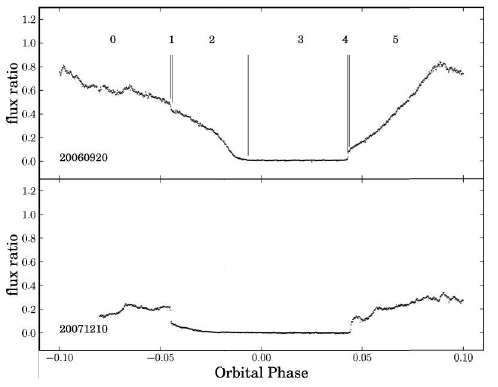
Figure 5: Eclipse light curves of HY Eri, at high (up- per curve) and low (lower curve) accretion